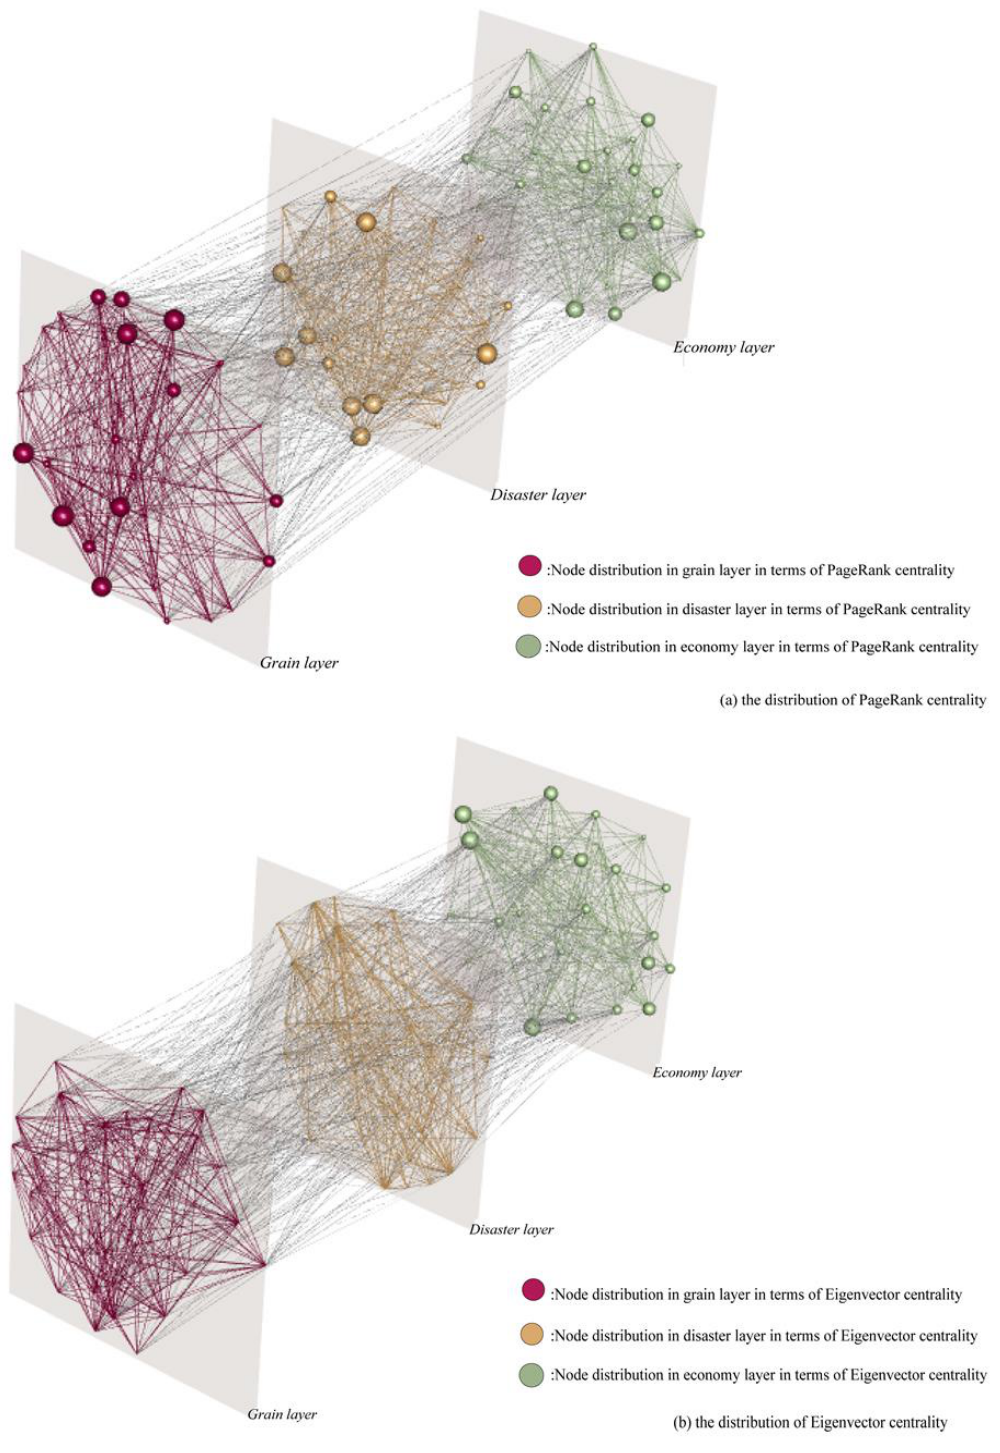
Figure 6. Centrality characteristics of grain–disaster–economy multilayer network.